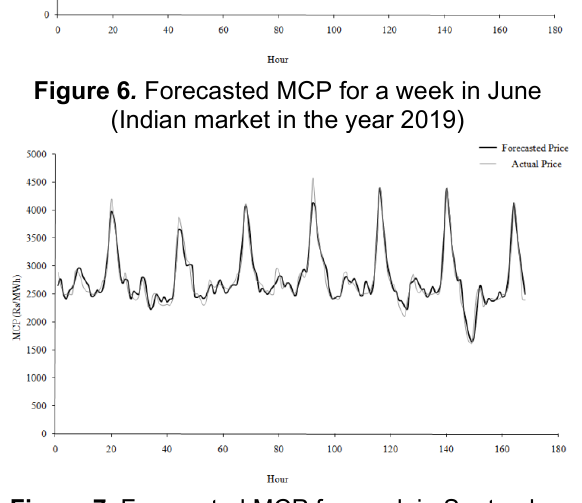
Figure 7 . Forecasted MCP for week in September